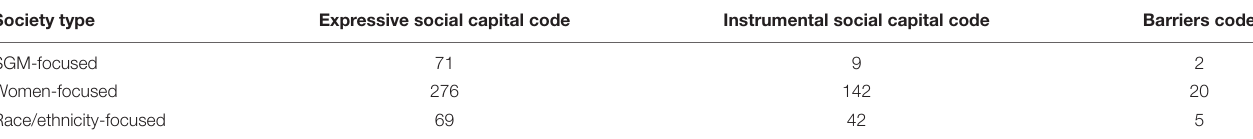
TABLE 4 | Count of codes applied to data across the three